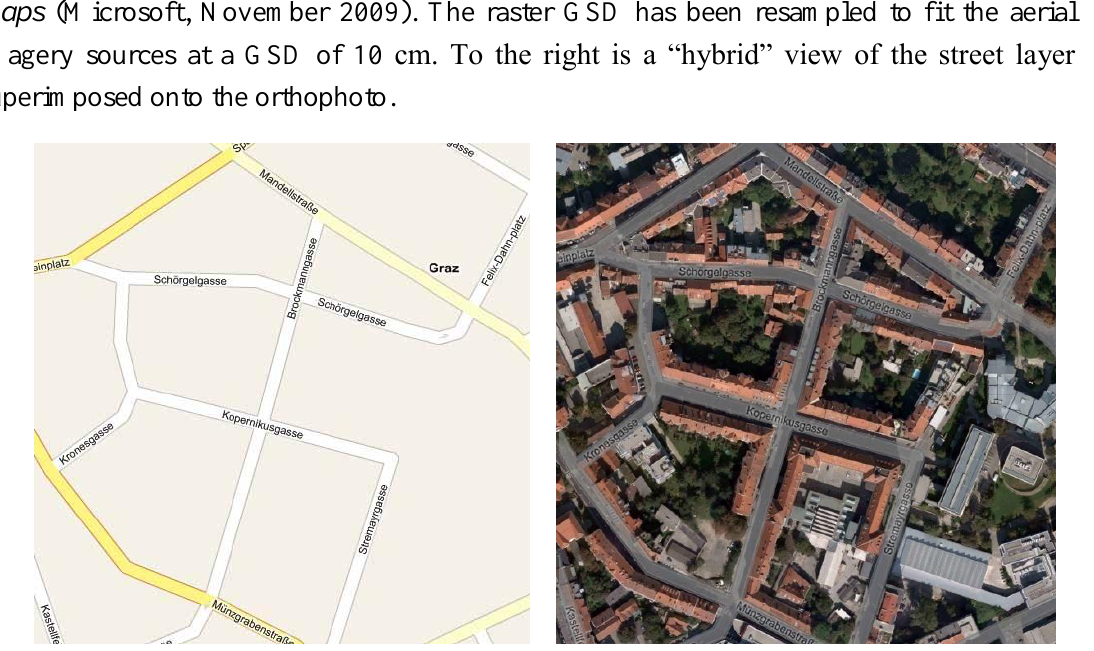
Figure 6. Street layer for the area in Figure 3 taken off the Internet search system Bing Maps (Microsoft, November 2009). The raster GSD has been resampled to fit the